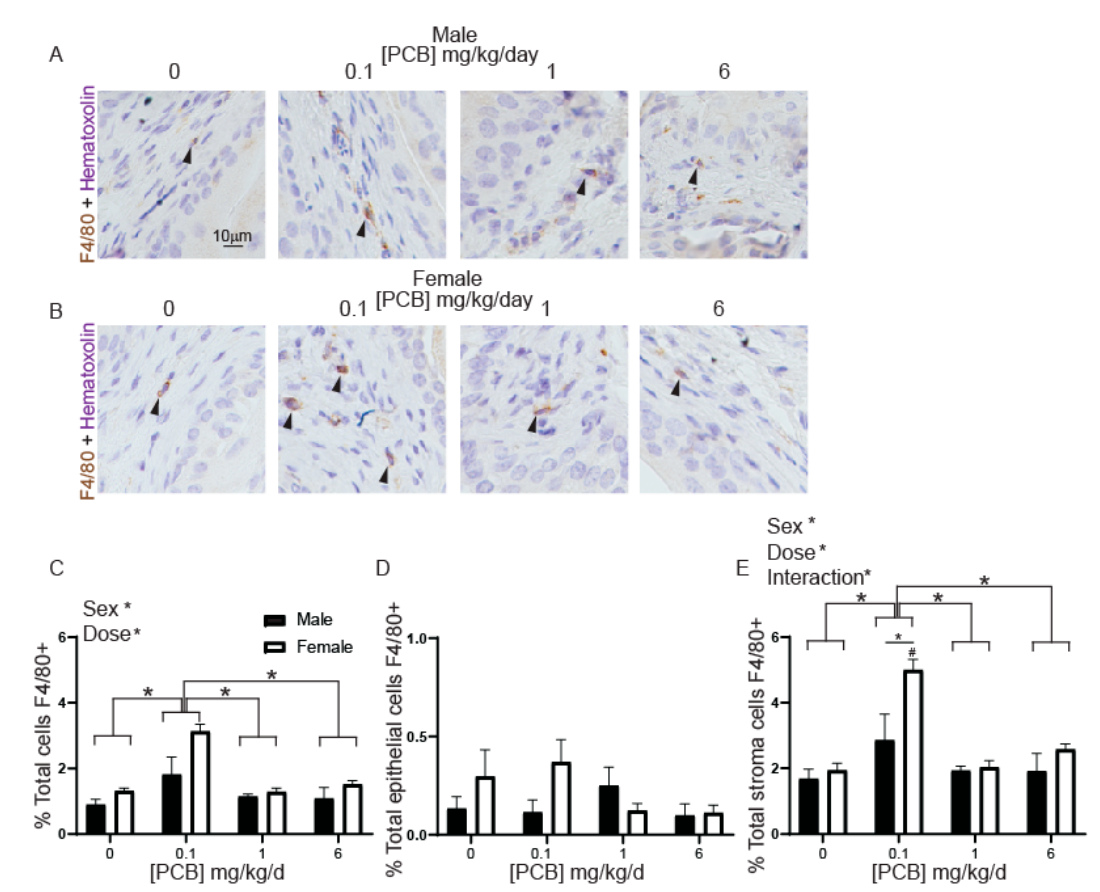
Figure 4. PCBs increase F4/80-positive cells in bladder of developmentally exposed female mice. Mice were exposed to PCBs via maternal diet through gestation and lactation and bladders collected from young male and female offspring at postnatal day (P) 28–31 for immunohistochemistry. Representative images of ( A ) male and ( B ) female mouse bladders at each PCB treatment group incubated with antibodies targeting F4/80 (brown) to label macrophages, nuclei were counterstained with hematoxylin (purple). Quantification of ( C ) percent total cells F4/80 positive, ( D ) percent total epithelial cells F4/80 positive, ( E ) percent total stromal cells F4/80 positive. Results are the mean ± SEM, n = 4–6 bladders per treatment group. Significant differences at p < 0.05 indicated by asterisk, asterisk and bars or by a # which indicates significant difference from all other same sex treatment groups as determined using two-way ANOVA followed by Tukey’s multiple comparisons tests.